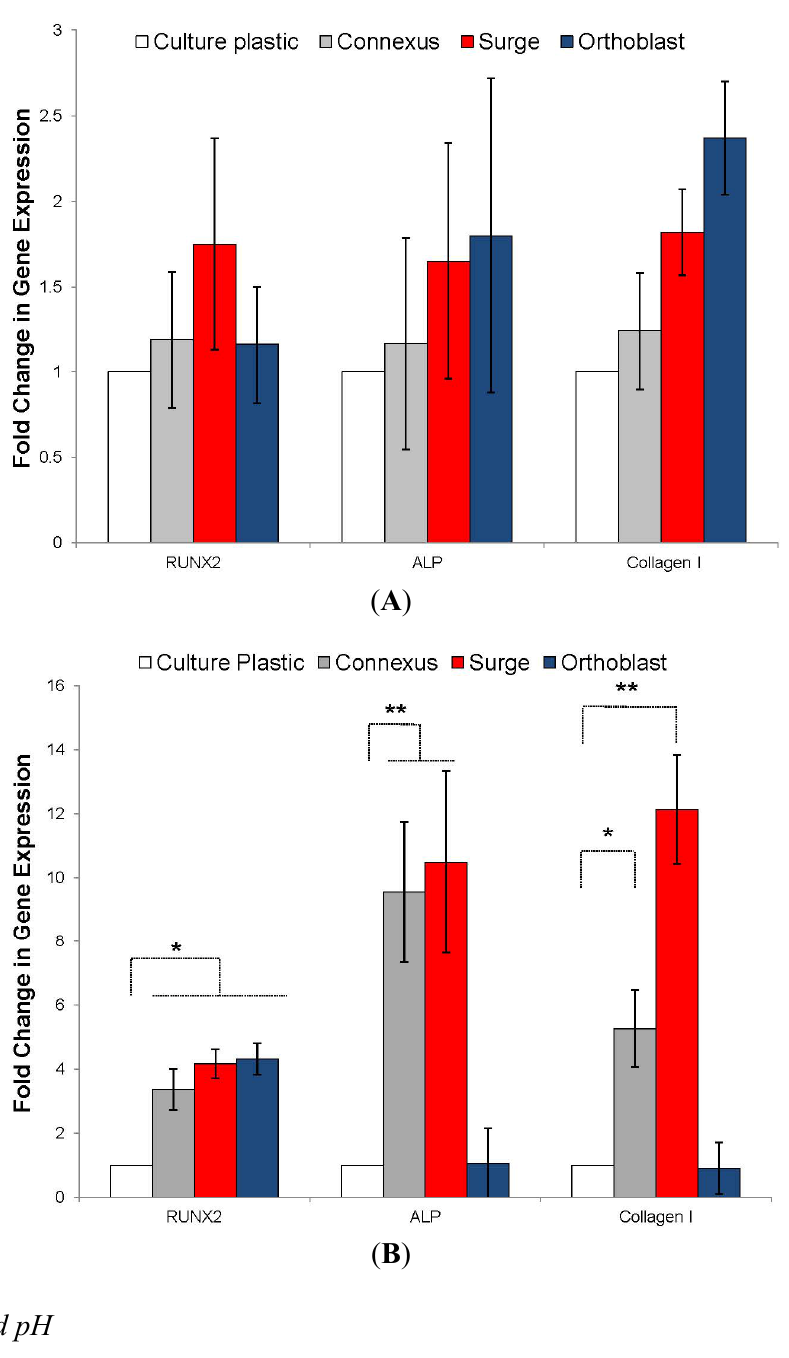
Figure 5. Relative expression of Runx2, alkaline phosphatase (ALP), and type I collagen as a fold increase over tissue culture plastic by cells cultured in 2D with 1:10 diluted extracts from DBM and DBM-poloxamer putties after four days ( A ) and eight days ( B ) of incubation at 37 °C. Error bars represent standard error of the mean ( n = 4 per substrate). Asterisks denote significant difference ( * p < 0.05, ** p < 0.01) by ANOVA and Tukey post